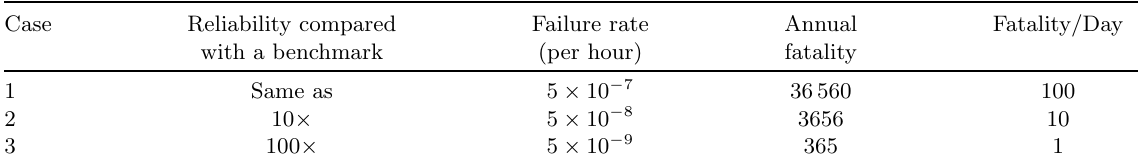
Table 3. Estimated fatality rates for automated